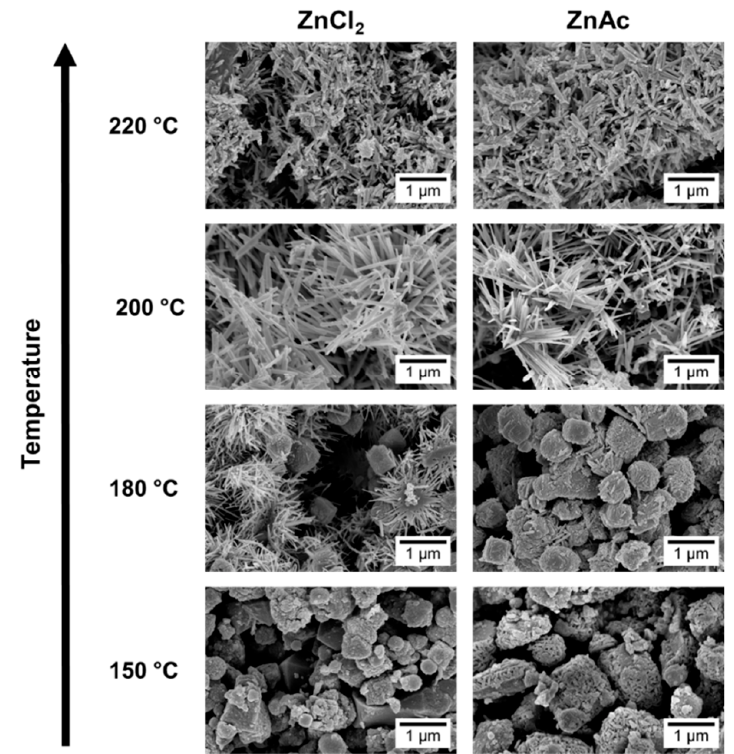
Figure 3. SEM images of the nanostructures obtained using the previous best conditions (15 mL) for each zinc precursor (ZnCl 2 and ZnAc) at different temperatures: 150 °C, 180 °C, 200 °C, and 220 °C. Increasing the temperature to 180 °C, some nanowires can be viewed in SEM when using the